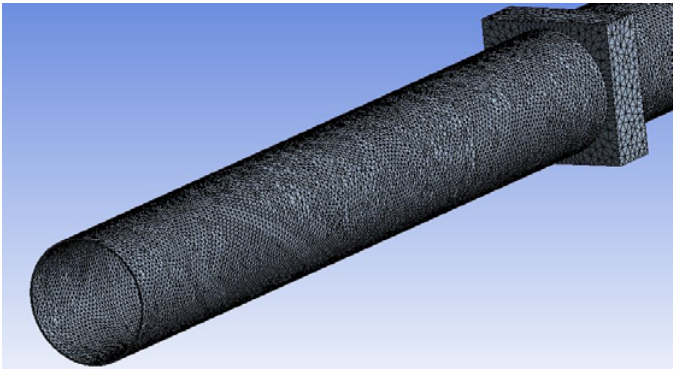
Figure 3 – Finite-element model of a tubular guide, modeled by the ANSYS finite- element analysis software